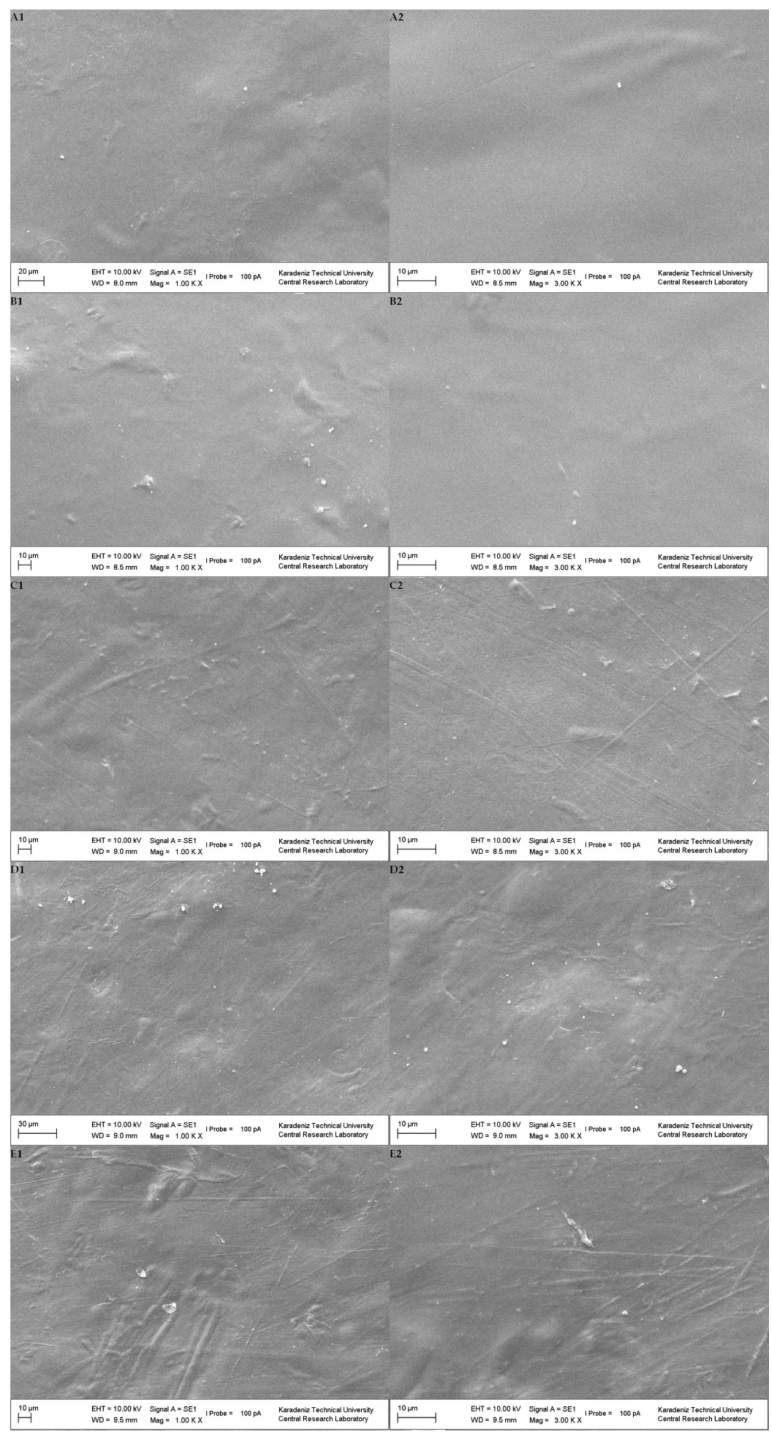
Figure 4. SEM micrographs, ( A1 ) CF (1000 × ); ( A2 ) CF (3000 × ); ( B1 ) 1% PF (1000 × ); ( B2 ) 1% PF (3000 × ); ( C1 ) 1% PSE (1000 × ); ( C2 ) 1% PSE (3000 × ); ( D1 ) 10% PF (1000 × ); ( D2 ) 10% PF (3000 × ); ( E1 ) 10% PSE (1000 × ); ( E2 ) 10% PSE (3000 ×